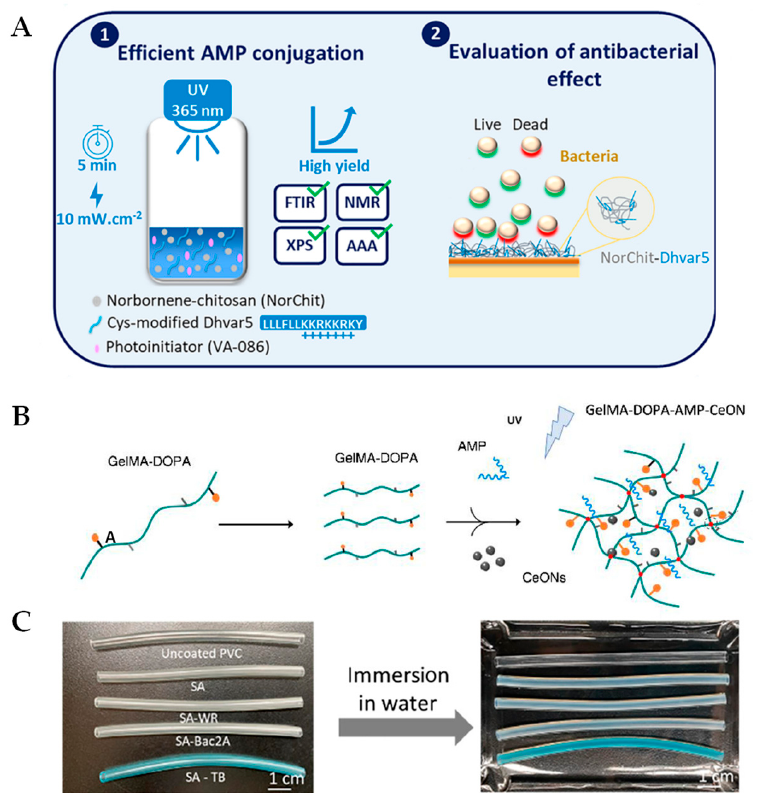
Figure 1. New photopolymerizable, antimicrobial hydrogel formulations created using UV light. ( A ) Norbornene-chitosan (NorChit) was exposed to the photoinitiator VA-086 and UV light (365 nm) at 10 mW/cm 2 for 5 min to initiate the conjugation of cysteine-modified Dhvar5 (NorChit- Dhvar5). The polymers were confirmed and analyzed by Fourier transform infrared spectroscopy